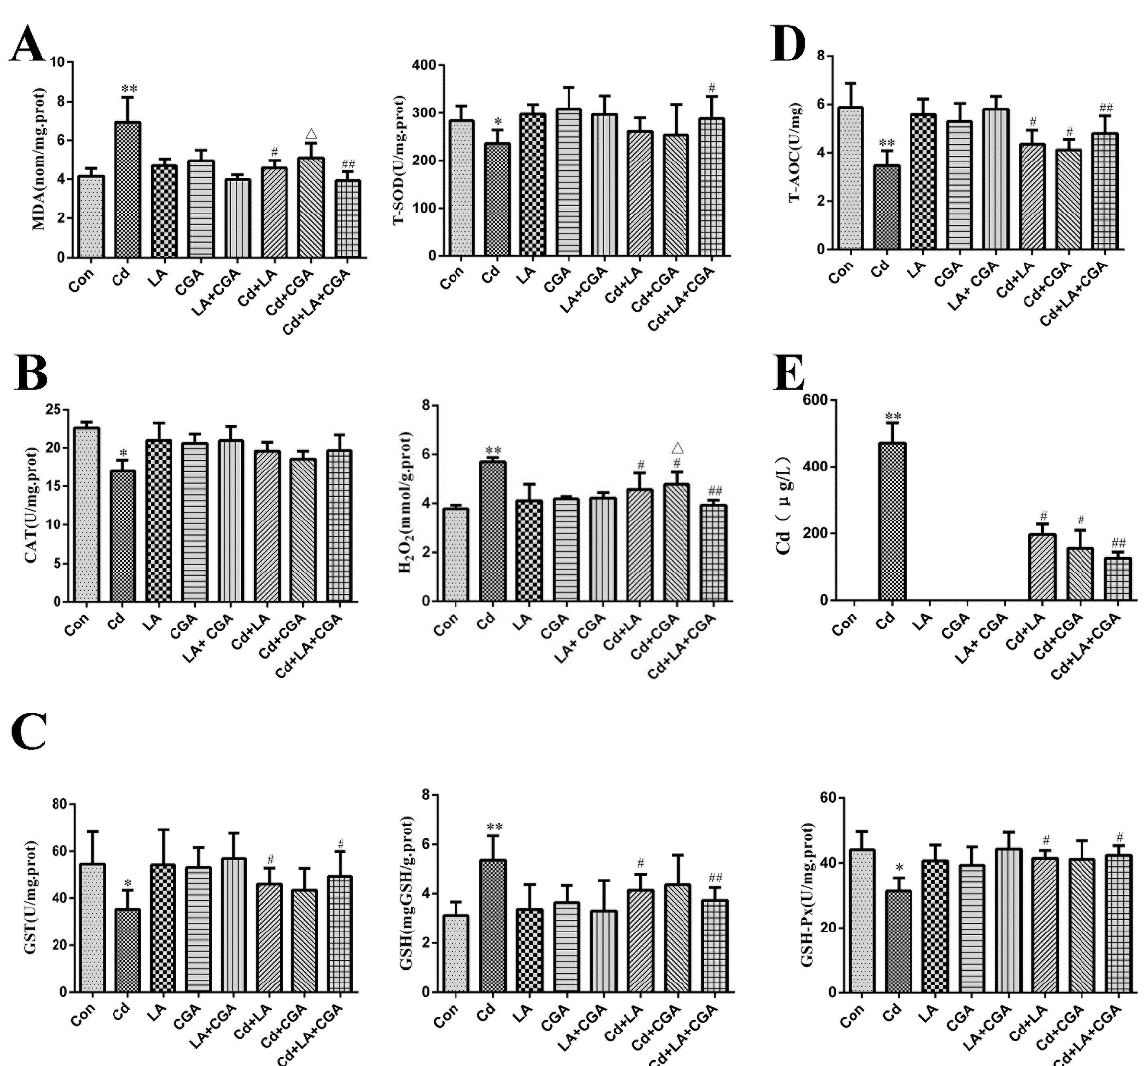
Figure 6. Effects of α -lipoic acid and chlorogenic acid on antioxidative properties and Cd concentration of cadmium-exposed chicken liver. ( A ) Thiobarbituric acid (TBA) method was used to measure the content of MDA. The T-SOD assay kit was used to detect the activity of T-SOD. ( B ) The activities of CAT and H 2 O 2 was measured by spectrophotometry according to CAT and H 2 O 2 assay kits. ( C ) Antioxidant parameters—GST, GSH and GSH-Px activities were detected by the GST, GSH and GSH-Px assay kits. ( D ) The activity of T-AOC represents total antioxidant capacity of body. ( E ) Concentration of Cd in liver was detected by ICP-MS. * p < 0.05, ** p < 0.01 vs. control, # p < 0.05, ## p < 0.01 compared to Cd-treatment group and ∆ p < 0.05 compared to α -LA + CGA + Cd group.